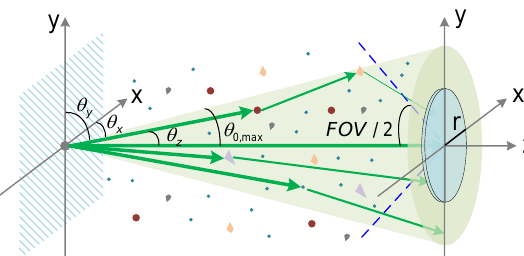
Figure 3. Schematic diagram showing the geometry of the transceiver and the moving trajectory of photons in seawater. θ x , θ y , θ z are the angles between the direction vector of the photon and the x, y, and z-axis, respectively. θ 0, max represents the maximum initial divergence angle of the beam and FOV represents the field of view of the receiver.